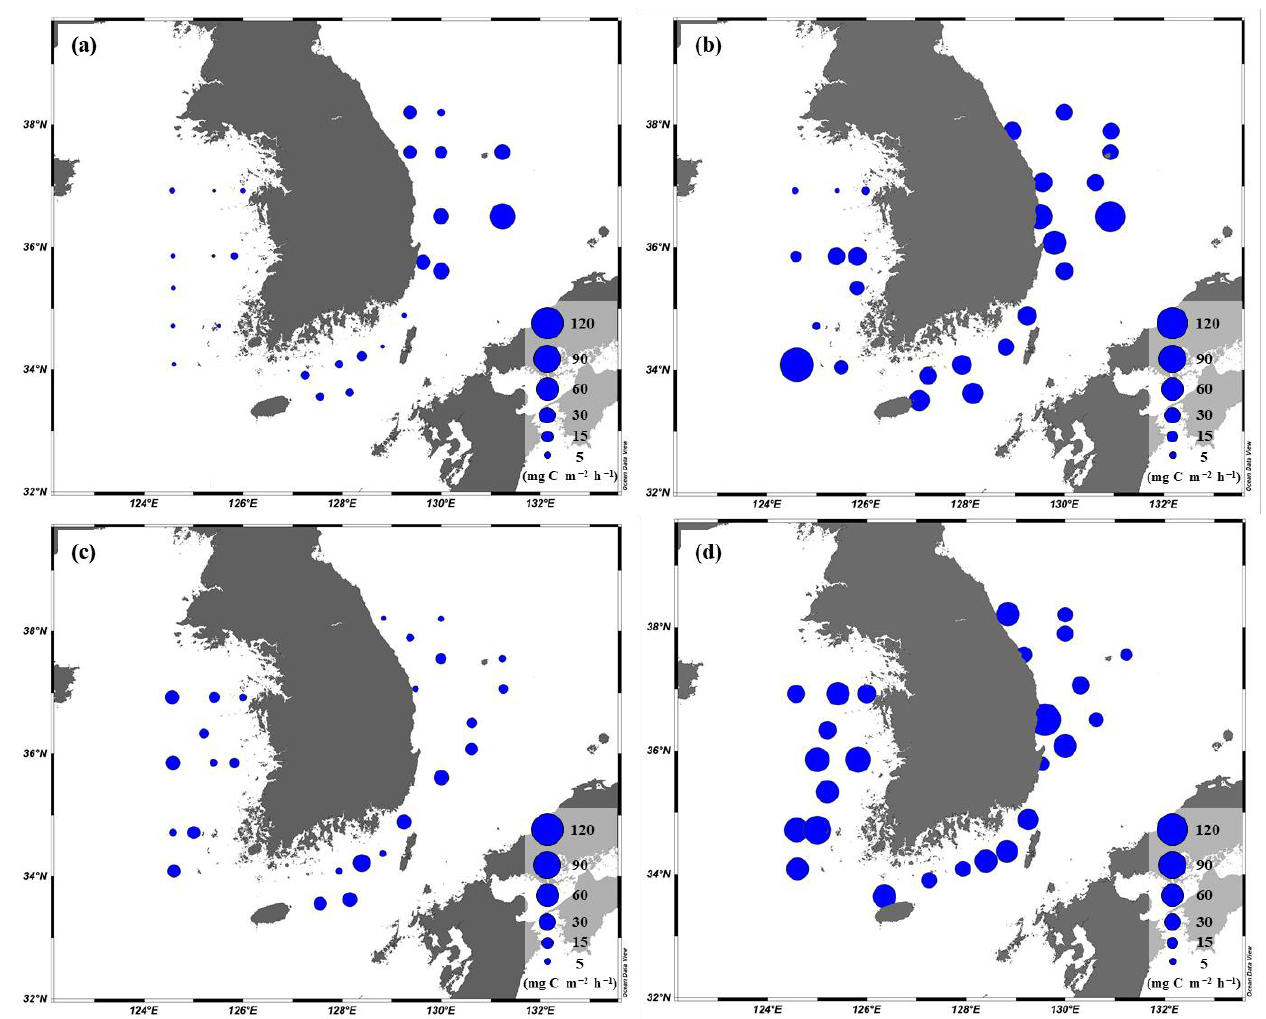
Figure 7. Spatial distributions of the primary production integrated within the euphotic depth from 100 to 1% light depth in